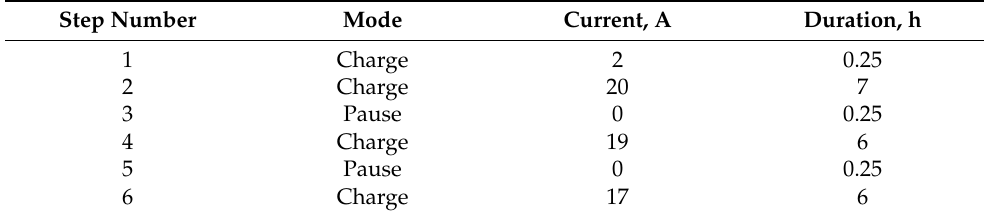
Table 2. Formation